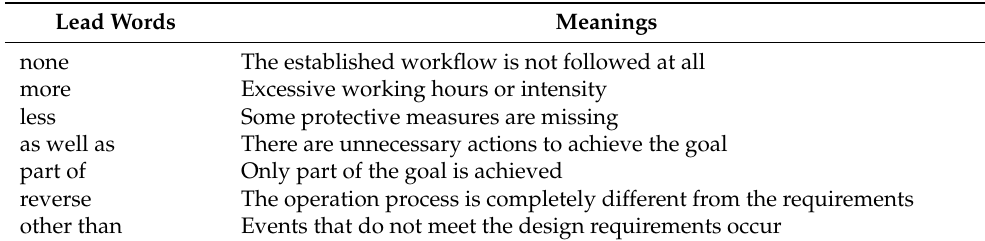
Table 2. Lead words and meaning of the HAZOP